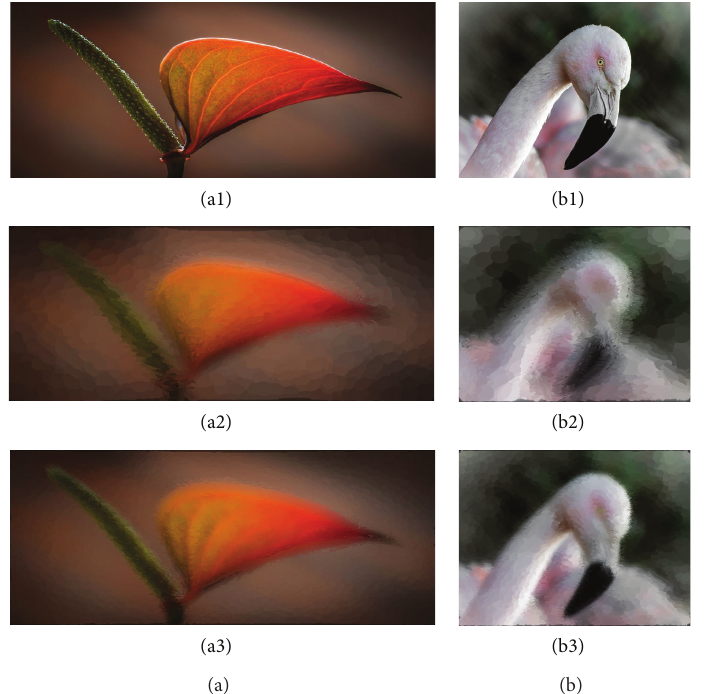
Figure 6: Flower and bird images’ Pointillism. 𝑁 = 21000 (a) and 𝑁 = 39000 (b). ((a1), (b1)) Source image with size: 1024 × 425 and 1024 × 777 ; ((a2), (a3)) with maximal/minimal dot size: 43/7 and 21/3; ((b2), (b3)) with maximal/minimal dot size: 79/9 and